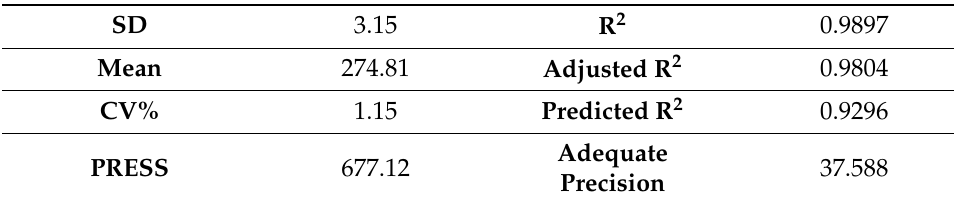
Table 3. Regression coefficients of final reduced